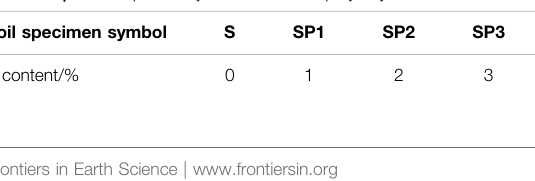
TABLE 4 | SP composite layer with different polyacrylamide